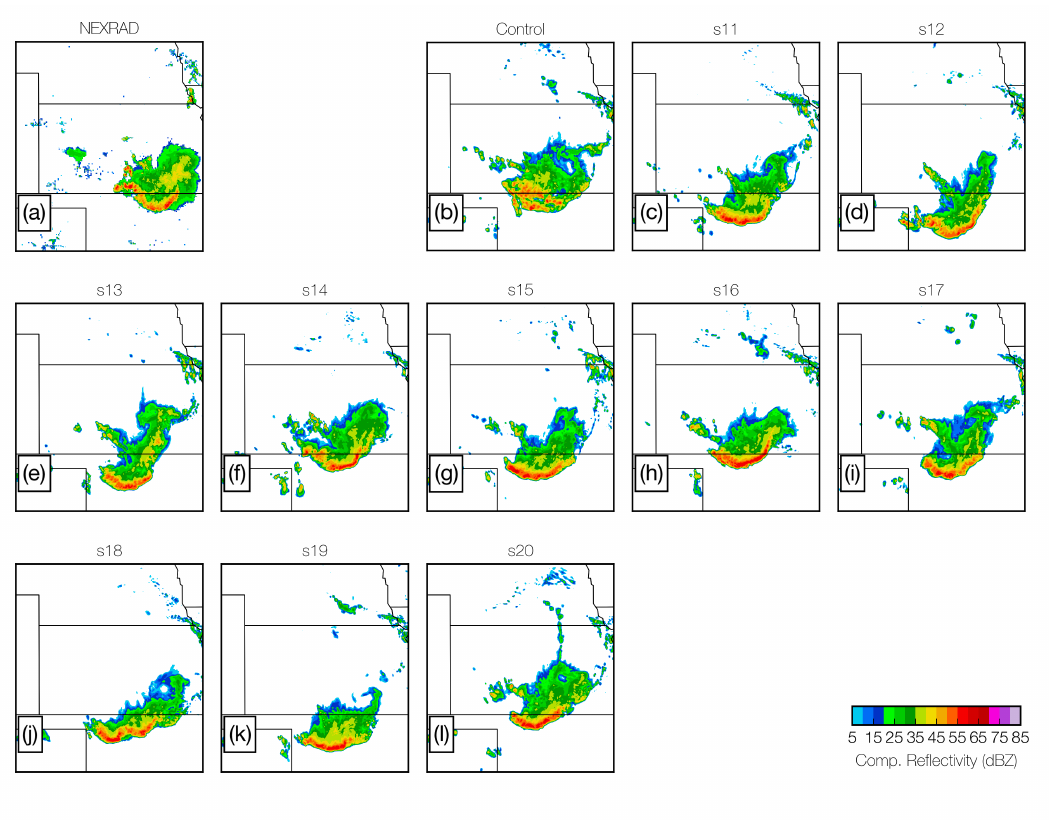
Figure 5. As Figure 4, but for the double-nest (3-km/1-km)